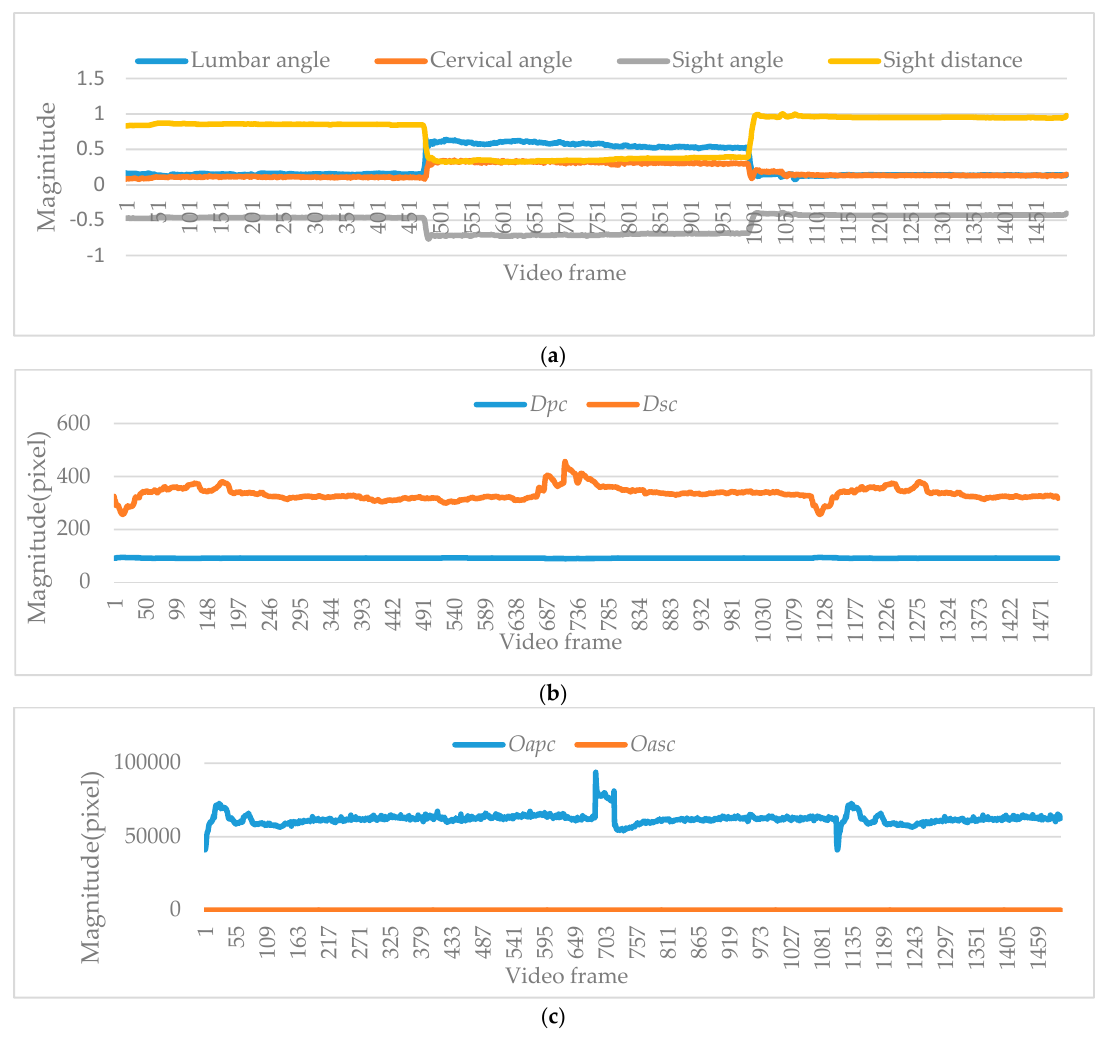
Figure 8. The semantic feature curves. ( a ) The semantic feature curves of lumbar angle, cervical angle, sight angle and sight distance. ( b ) The semantic feature curves of distance between person and chair, distance between screen and chair. ( c ) The semantic feature curves of overlapping area between person and chair, overlapping area between screen and chair.